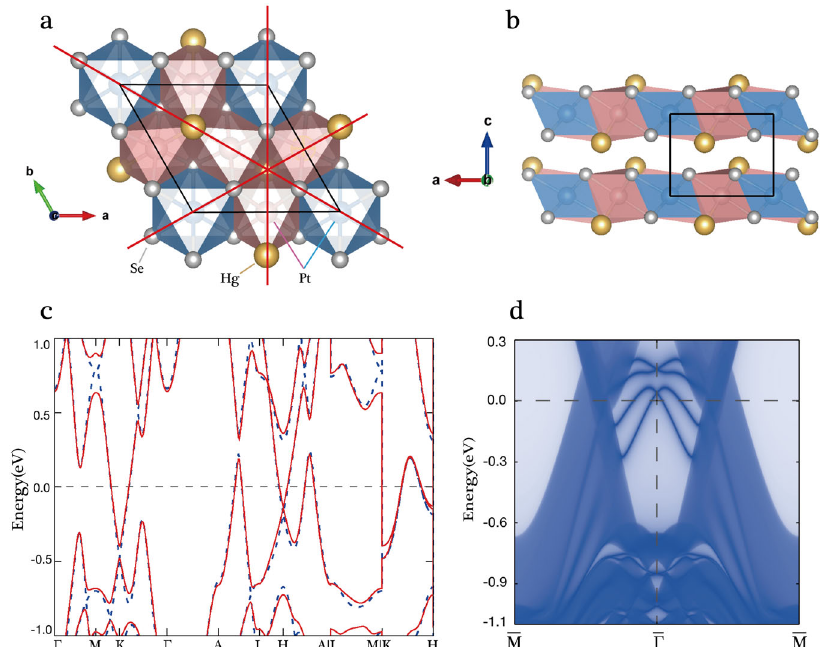
Fig. 1 Crystal and electronic structures of Pt 2 HgSe 3 . a , b Crystal structure of Pt 2 HgSe 3 . Pt1 and Pt2 octahedra that are shown in blue and red, respectively, denote two symmetry inequivalent local environments of Pt atom in the unit cell. c Electronic structure of Pt 2 HgSe 3 . d The corresponding states at (001)